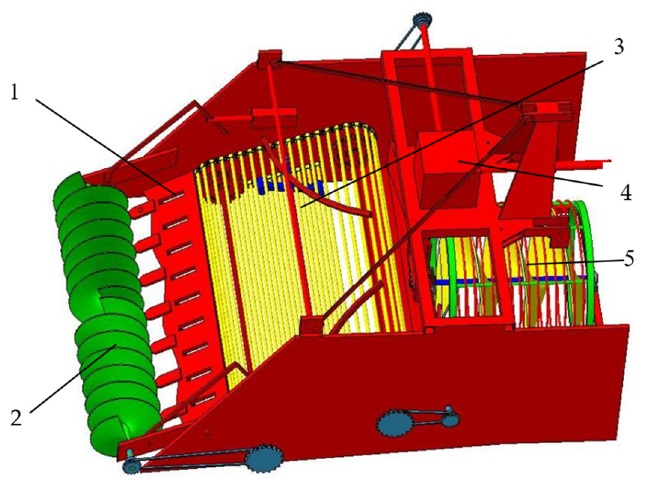
Figure 1. Lily harvester structure diagram. 1. Digging shovel; 2. Spiral digging knife; 3. Front conveyor; 4. Gearbox; 5. Flexible separation device.